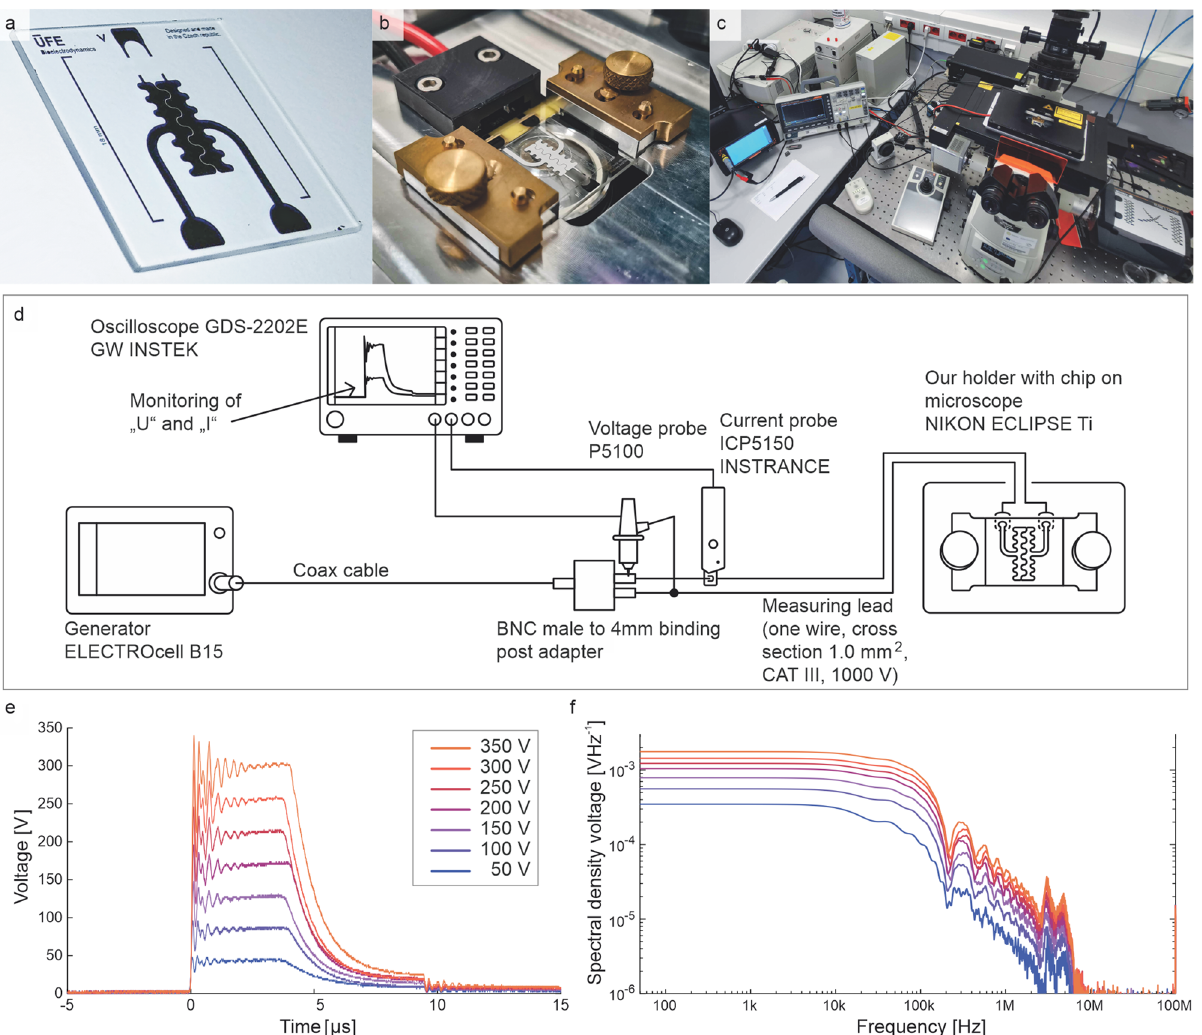
Figure 2. Fabricated chip platform and experimental setup. (a) Fabricated chip. (b) Fabricated chip platform mounted on a Nikon Eclipse Ti TIRF microscope stage. (c) A photograph of the experimental pulse electric field setup. (d) A scheme of the experimental pulse electric field setup. (e) Typical pulse shapes of used pulses, legend shows the voltages set on the electric pulse generator. (f) Voltage spectral density recalculated from recorded